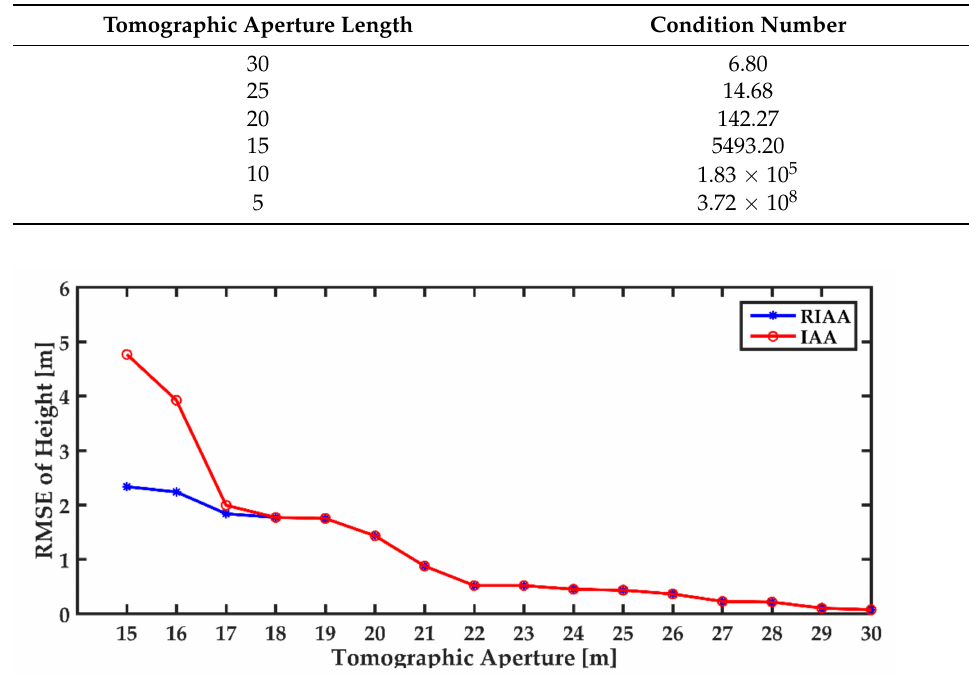
Figure 4. Reconstructed reflectivity profiles by the RIAA and IAA methods with different tomographic apertures in the third scattering scenario: ( a ) 30 m; ( b ) 25 m; ( c ) 20 m; ( d ) 15 m; ( e ) 10 m; ( f ) 5 m. The black solid lines are the true simulated reflectivity profiles. The blue solid lines are the reconstructed reflectivity profiles of RIAA. The red dotted lines are the reconstructed reflectivity profiles of IAA. Table 3. Condition number of the covariance matrix with different tomographic apertures.